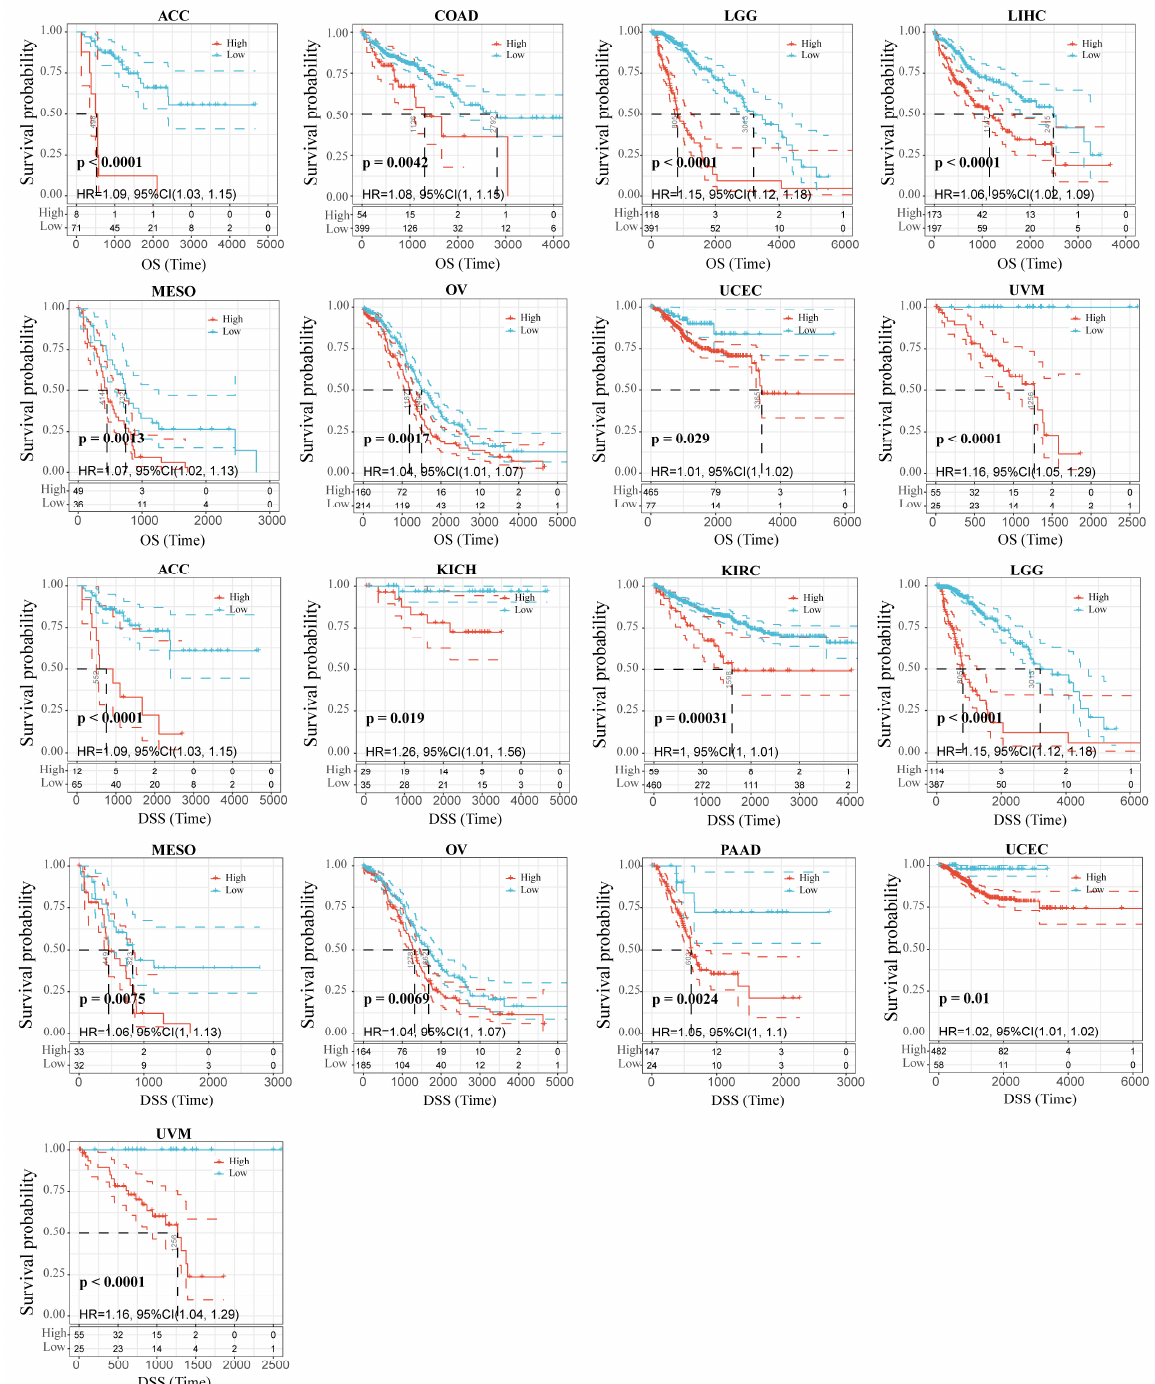
Figure 2. Correlation between RAB42 expression and OS and DSS.